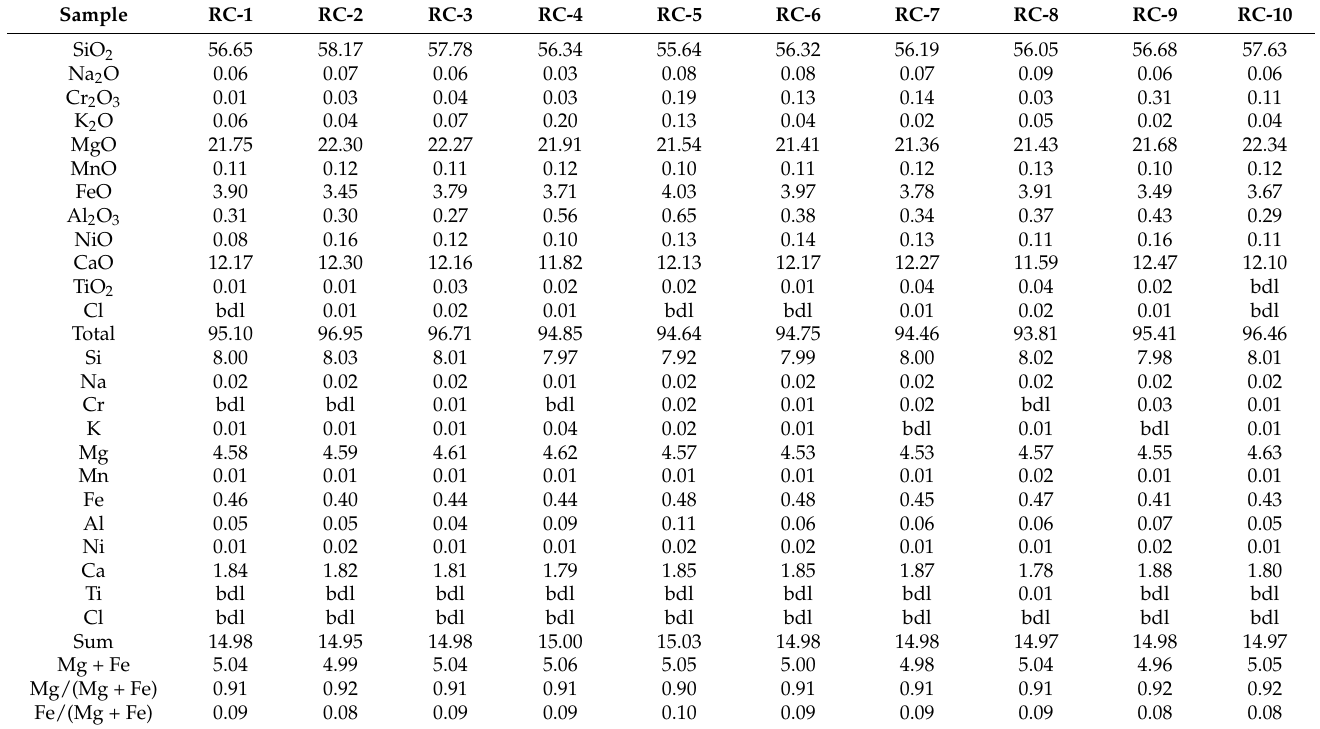
Table 1. Electron probe microanalysis of tremolite in the selected samples